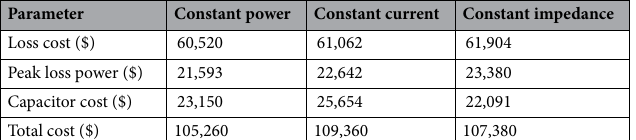
Table 14. Different amounts of cost in the network after the capacitor placement in the mode of cosφ = 1.